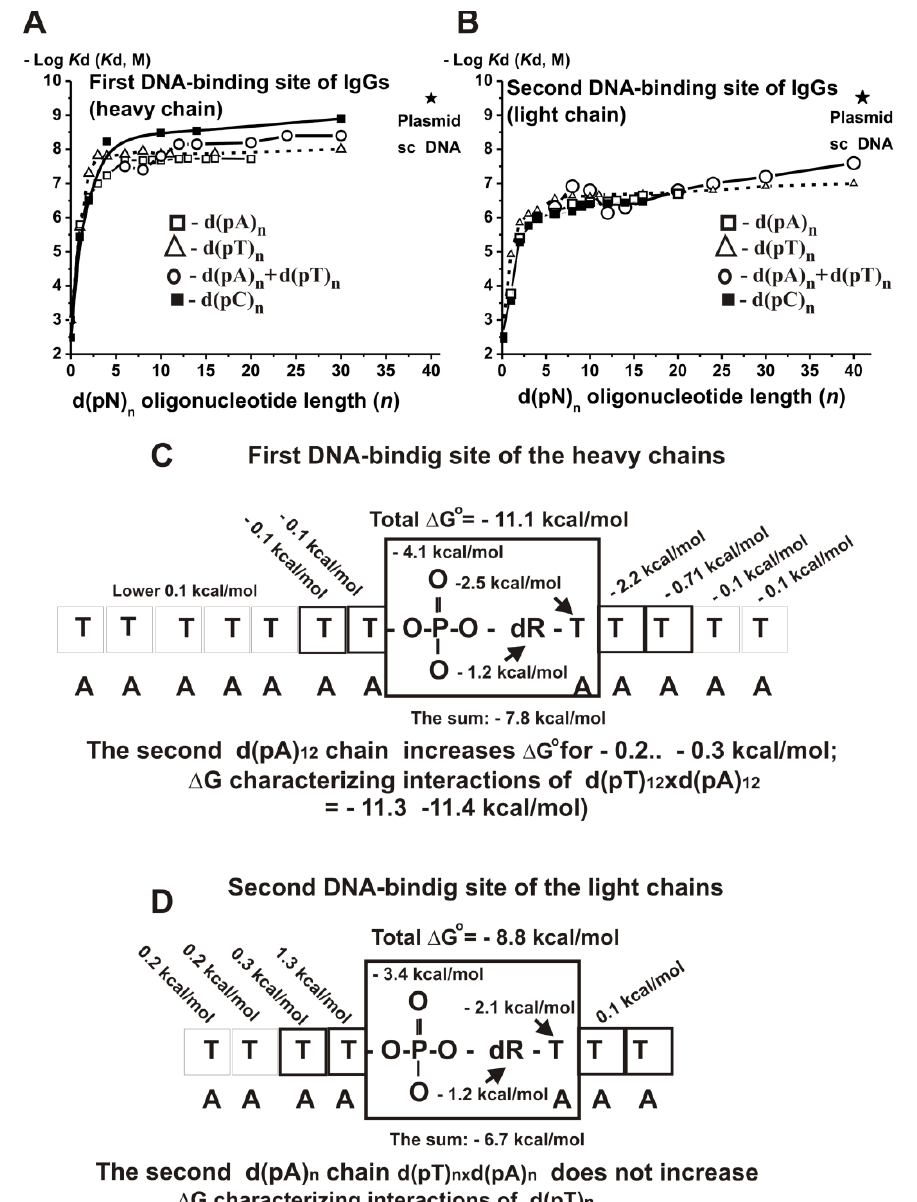
Figure 20. The − Log dependences of K d values for d(pN) n corresponding to the first ( A ) and second ( B ) sites of anti-DNA IgGs upon ODNs length [137]. Different ss and ds ODNs are shown on the Panels ( A , B ). The average error in the complex formation from two independent experiments did not exceed 7–10%. Thermodynamic models of d(pT) n interaction with the heavy ( C ) and light ( D ) chains of IgGs. Values ∆G° are given on the Panels ( C , D ).